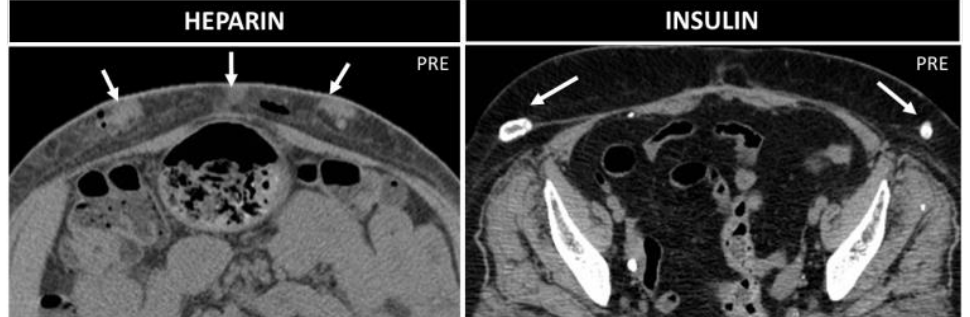
Figure 14. Heparin vs. insulin treatment nodules in two 70-year-old patients. Axial not-enhanced CT in the first patient shows some collections with parenchymatous density, which indicate bleeding, and small air bubbles. In the second patient, instead, lipodystrophies with peripheral calcifications are seen.